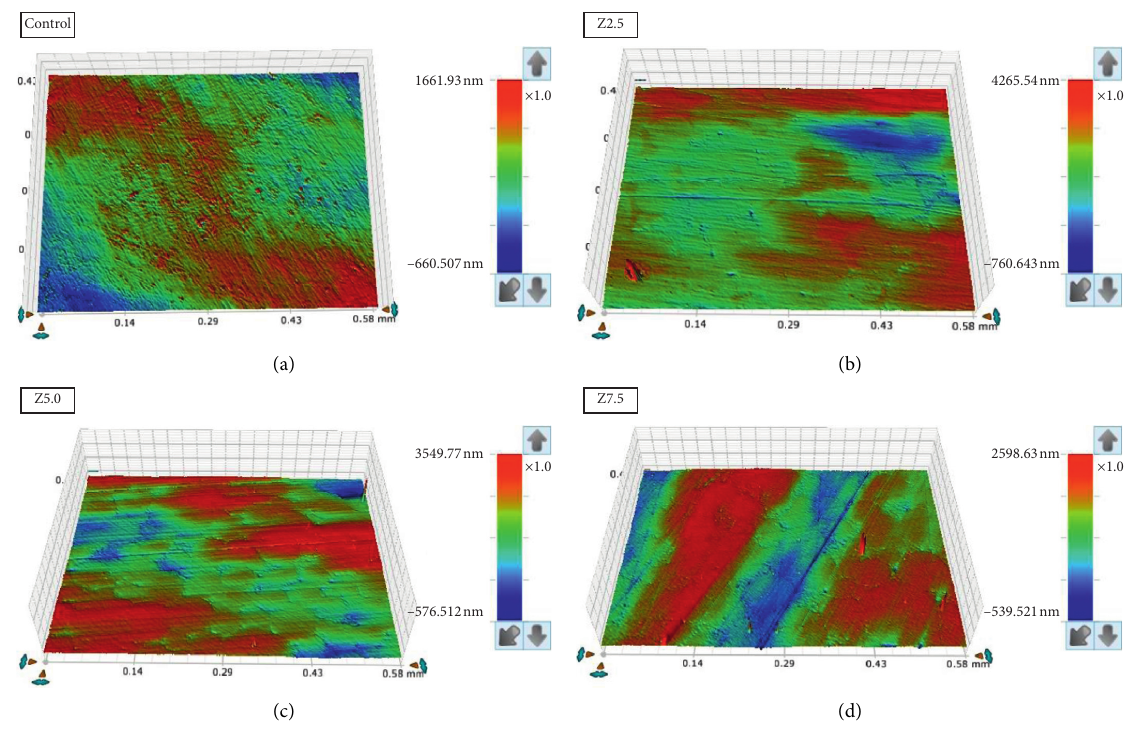
Figure 2: Images of surface roughness profile of